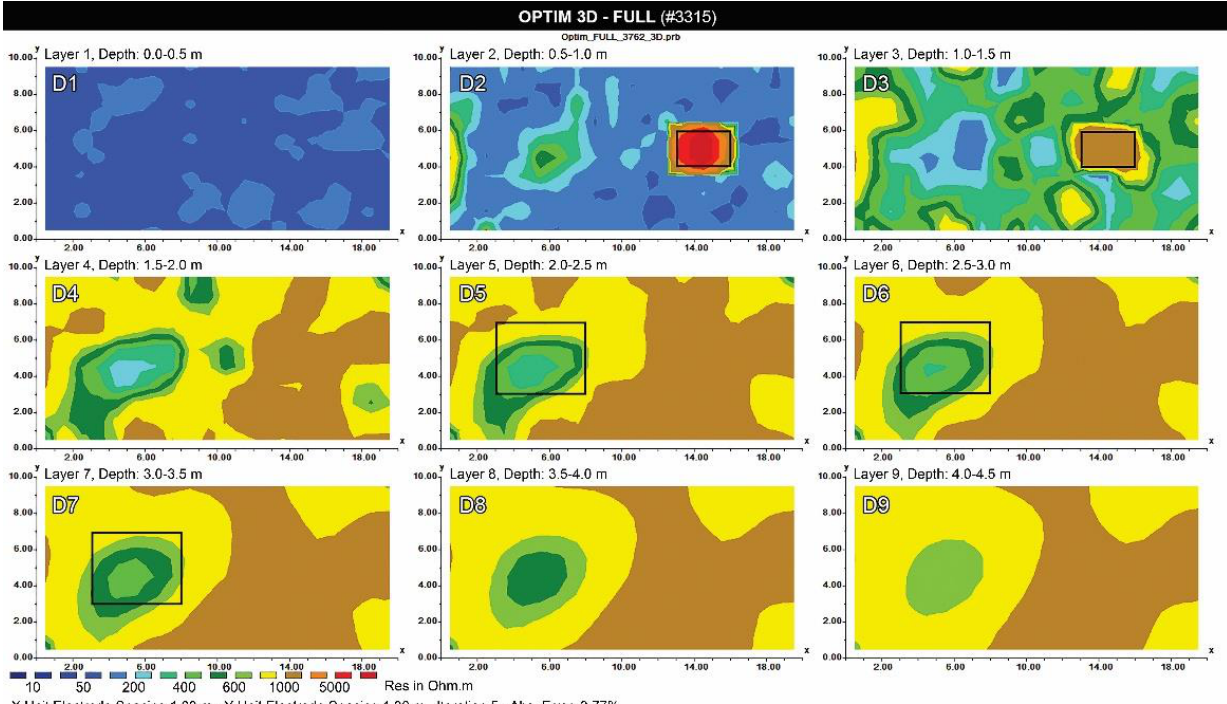
Figure 9. Inversion results from optimum array produced by 3D algorithm. Stummer’s optimum data reconstruct target ‘A’ only at layer D2 (not at D3) with higher resistivity values (>5000 ohm.m) and deformed along the Y direction (Figure 10). The layer D2 is reconstructed with values close to 1000 ohm.m, a value higher than the model (100 ohm.m). Target ‘B’ is also reconstructed at depth layers D3 and D4, where it should not be, but with resistivity values closer to the theoretical model (100 ohm.m).